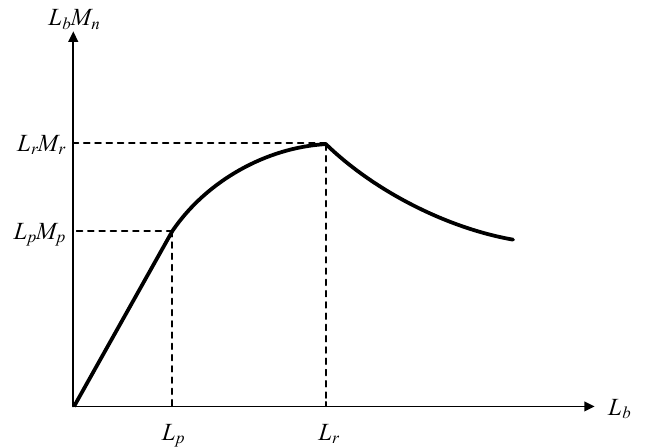
Figure 6. Relationship between unbraced length ( L b ) and LM index (L b M n ) in hot-rolled H-beam.